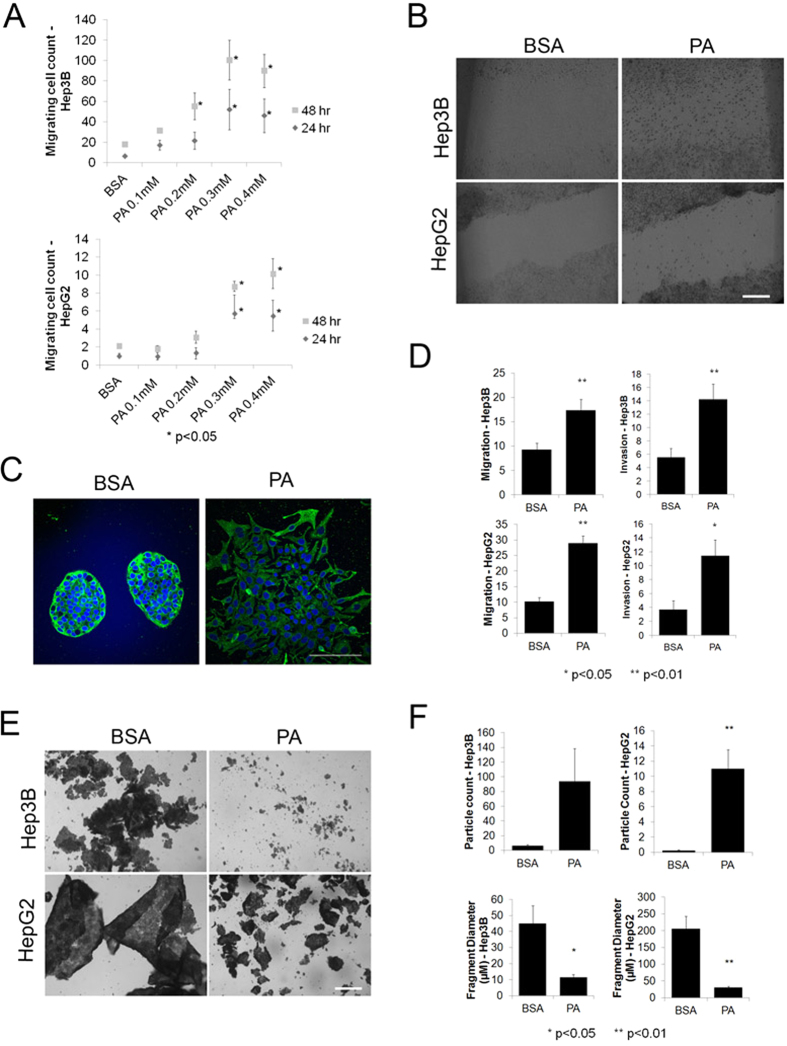
PA mediated EMT induction.(A) Scratch-wound cell migration assays with HepG2 and Hep3B cells treated with different concentrations of PA (0.1 mM to 0.4 mM) and BSA (control). The plot indicates average number of migrating cells in the wound area at 24 and 48 hours following 5-day treatment normalized to 0 hour time point (n = 3). P-values indicate the significance levels compared to BSA at a given time point determined by Tukey’s test following one-way ANOVA. (B) Phase contrast microscopy images of HepG2 and Hep3B cells treated with BSA or PA (0.3 mM) at 48 hours (40× magnification, scale bar = 50 μm). (C) Confocal images of HepG2 demonstrating changes in morphology upon PA treatment. Keratin 18 and nuclear staining are indicated by green and blue fluorescence respectively. (40× magnification, scale bar = 100 μm). (D) Modified Boyden’s chamber assays with HepG2 and Hep3B cells. The bar graph indicates the average number of migrating or invading cells (±SEM, Standard Error of the Mean) counted in 5 fields of view per insert (n = 3). P-values indicate significance levels determined by Student’s t-test (two-tailed). (E) Bright field images at 5× (scale bar = 400 μm) magnification showing fragmentation in monolayers of BSA or PA treated Hep3B or HepG2 cells following dispase treatment and application of mechanical stress. (F) Particle analysis following dispase assay. Bar graphs showing average particle count and fragment diameter (±SEM) determined from 5 independent images panels obtained after dispase treatment and applying mechanical stress to BSA or PA treated HepG2 and Hep3B cells. P-values indicate significance levels determined by Student’s t-test.